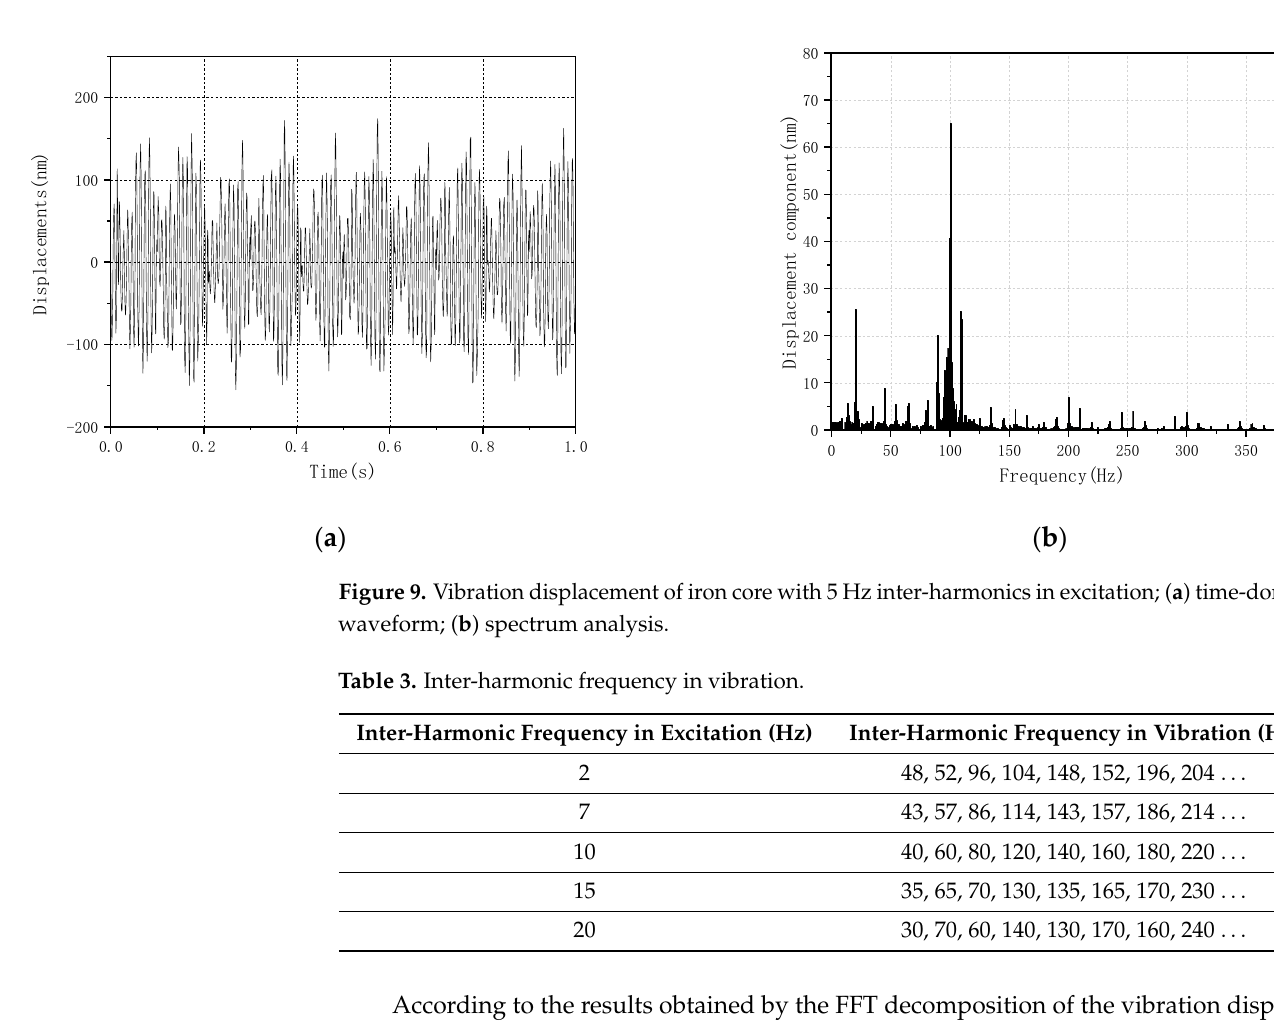
Table 3. Inter-harmonic frequency in vibration.